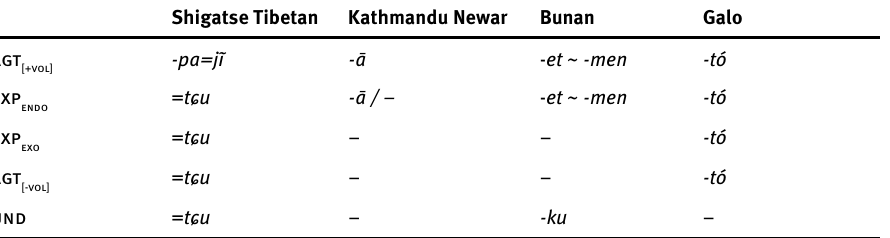
Table 8. Egophoric marking and semantic roles in the past / perfective constructions of four Tibeto-Burman languages Shigatse Tibetan Kathmandu Newar